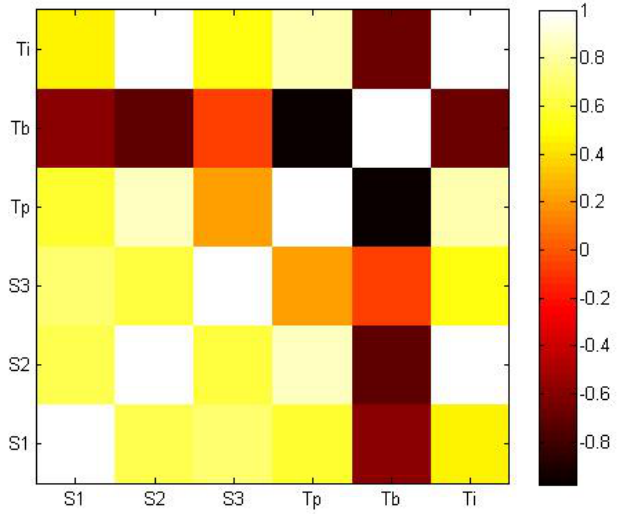
Figure 4. Correlation matrix containing Pearson’s correlation coefficients for each pair of variables: Light colours represent strong positive linear correlations, whereas dark colours document negative correlations. Orange suggests no correlation. Variables correspond to student’s marks in session 10 (S1), student’s final PTD evaluation criteria (S2), student’s increase between final and initial PTD evaluation criteria (S3), teacher’s performance during support (Tp), teacher’s initial level of programming